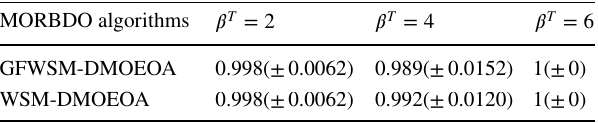
Table 15 The accuracy index Acc of the two MORBDO algorithms on the third MORBDO test example with different target reliability levels. Each result is in the form of mean ± standard deviation MORBDO algorithms 𝛽 T = 2 𝛽 T = 4 𝛽 T = 6